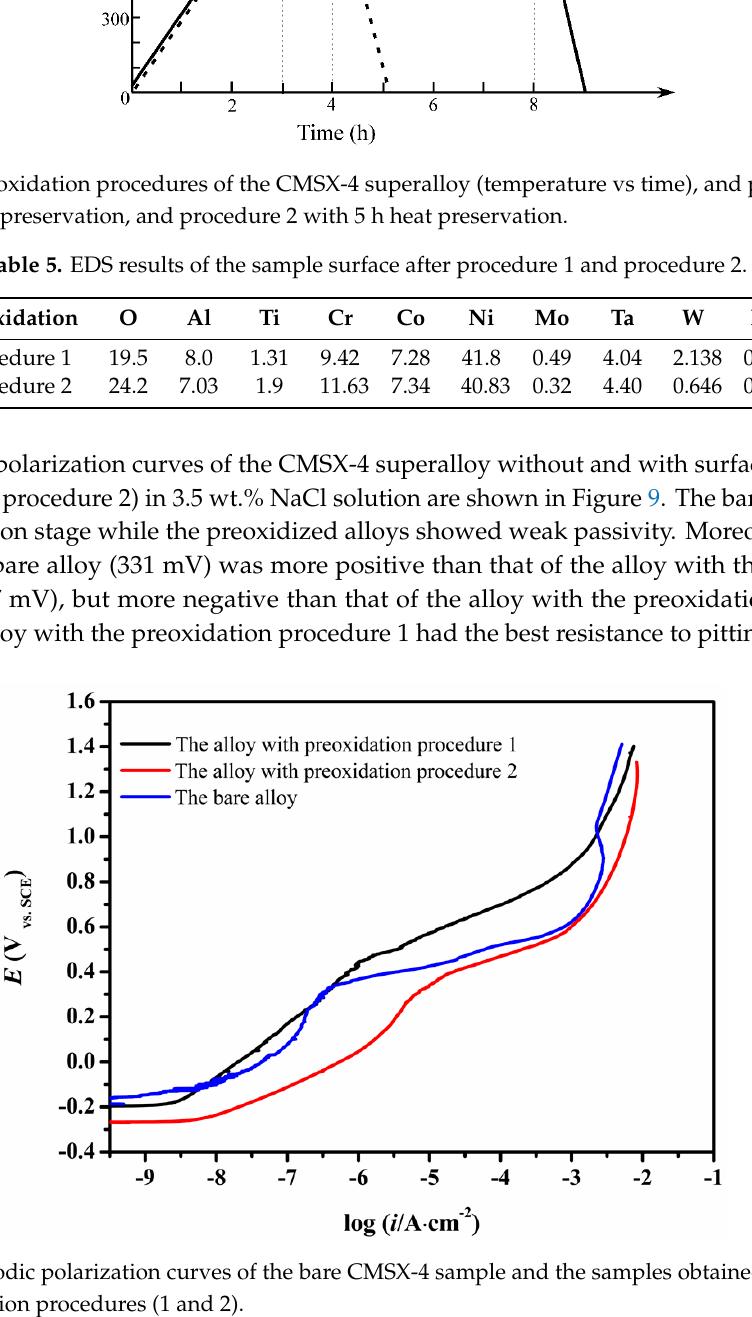
the preoxidation procedures (1 and 2).